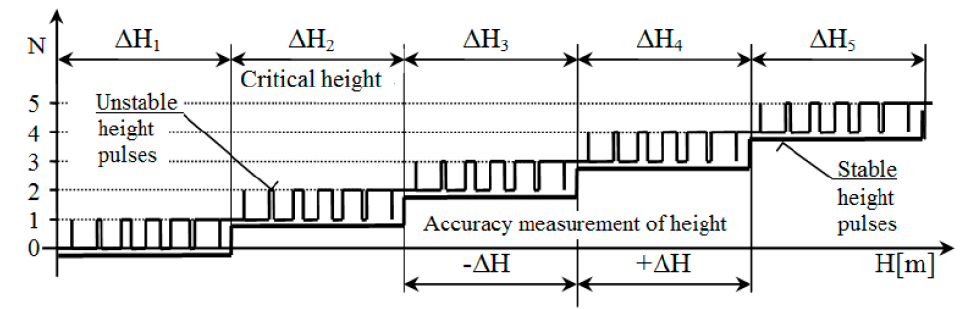
Figure 2. Relation between the critical altitude and measurement accuracy.